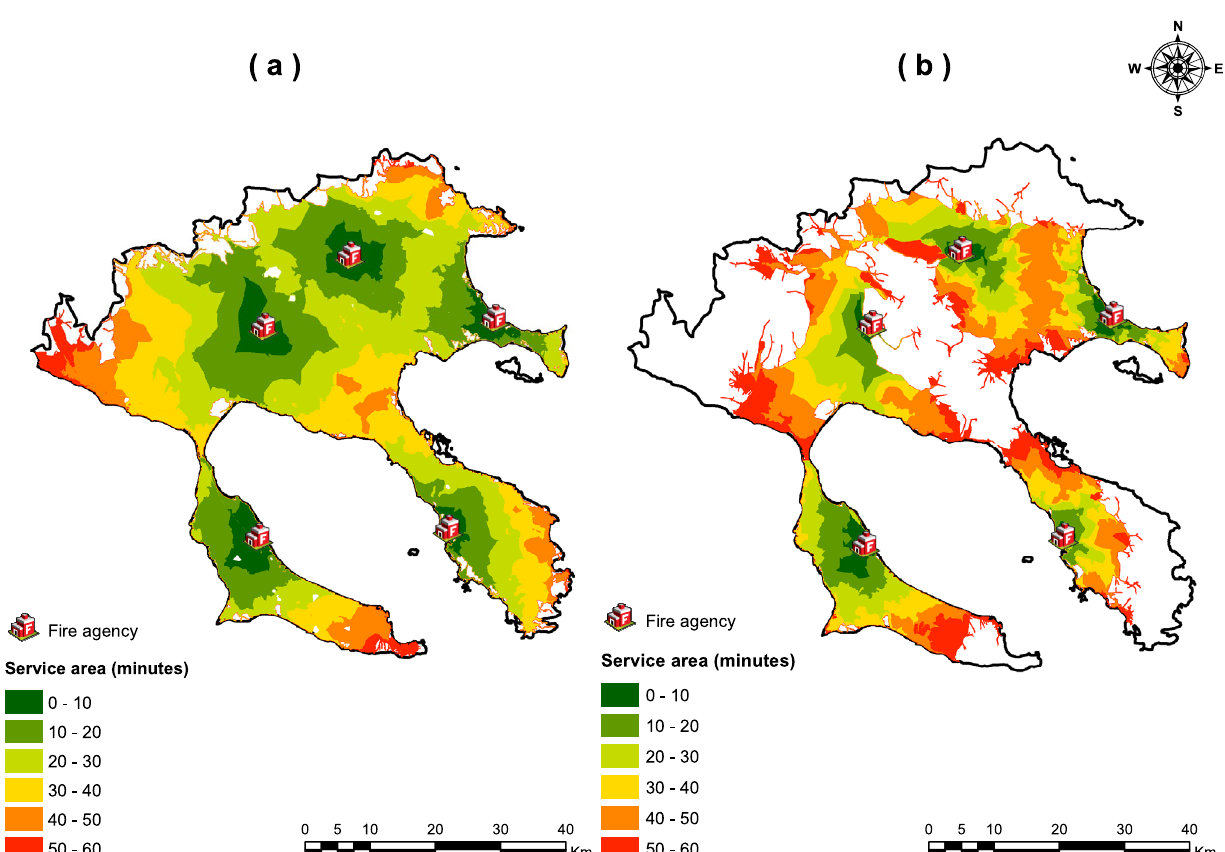
Fig. 5 Service area of fire agencies a without slope effect, and b with slope effect in the Chalkidiki study